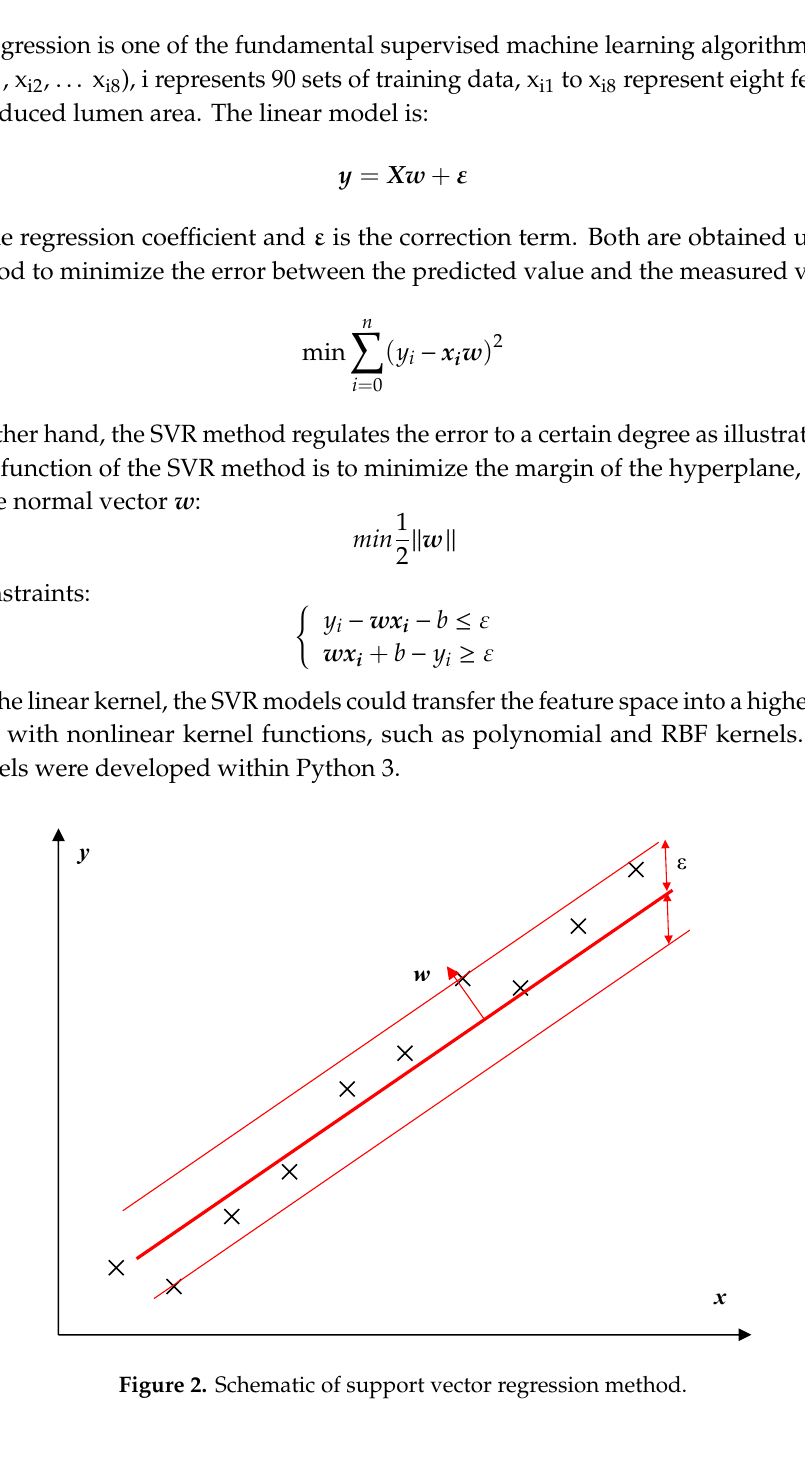
Table 1. Material coefficients.